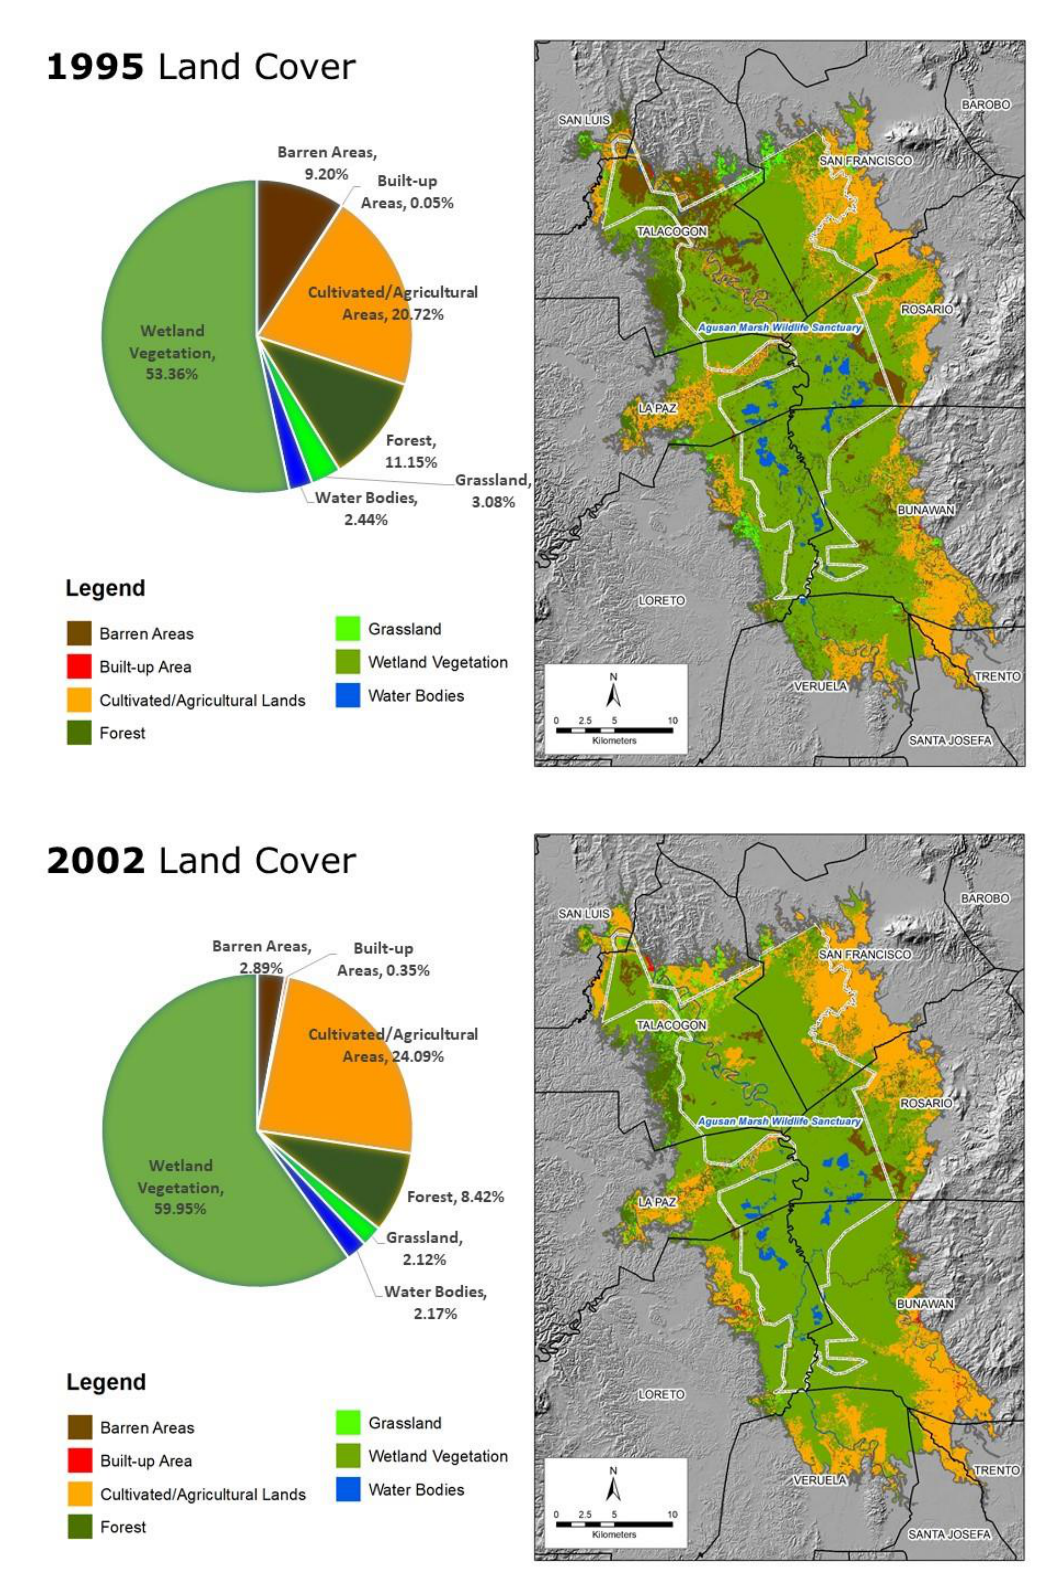
Figure 4 . Land-cover maps and statistics of the Agusan Marsh derived from multi-temporal Landsat images for the years 1995 and 2002. The polygon with white outline is the Agusan Marsh Wildlife Sanctuary